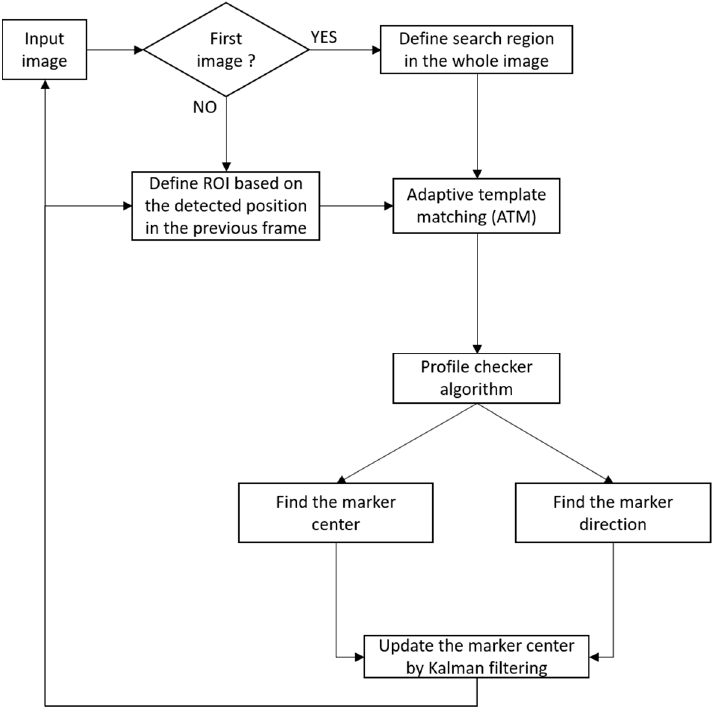
Figure 3. Flowchart of proposed marker-based tracking algorithm during daytime.